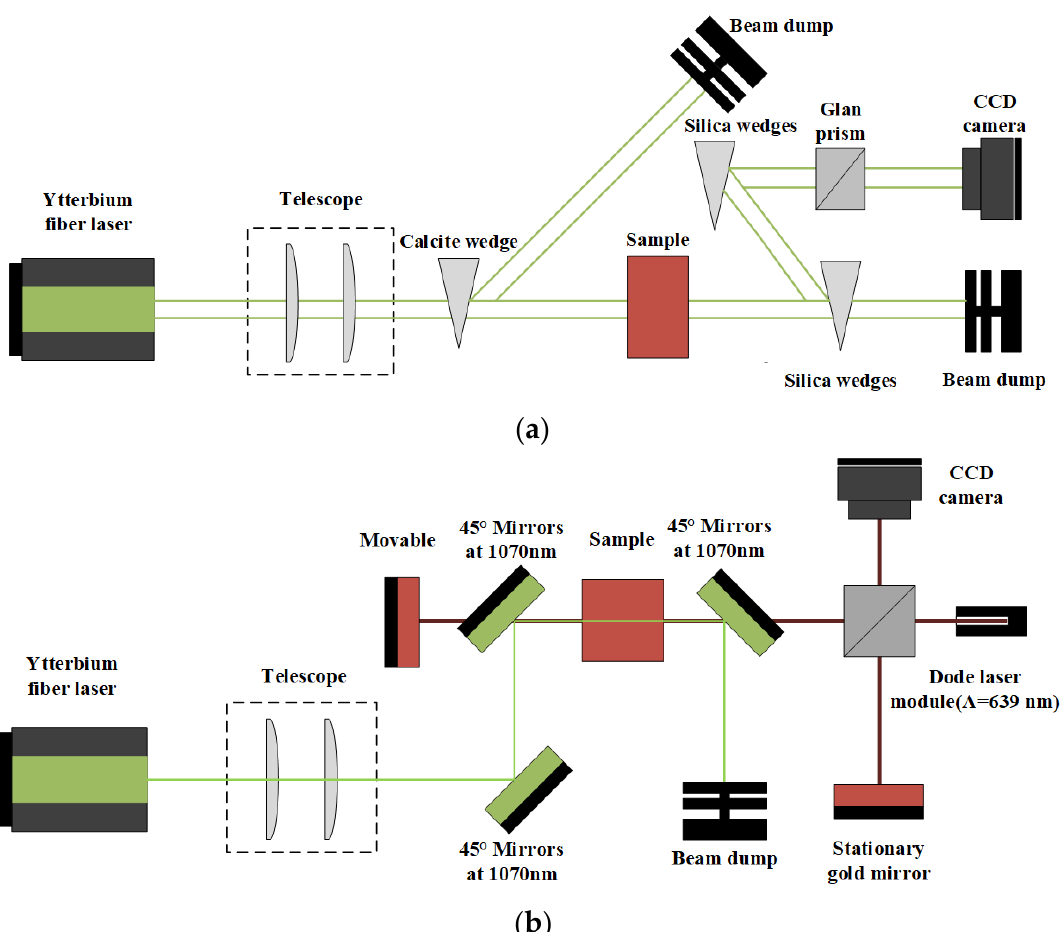
Figure 9. Scheme of the experiment of ( a ) thermal depolarization measurement and ( b ) studying thermally induced lens.